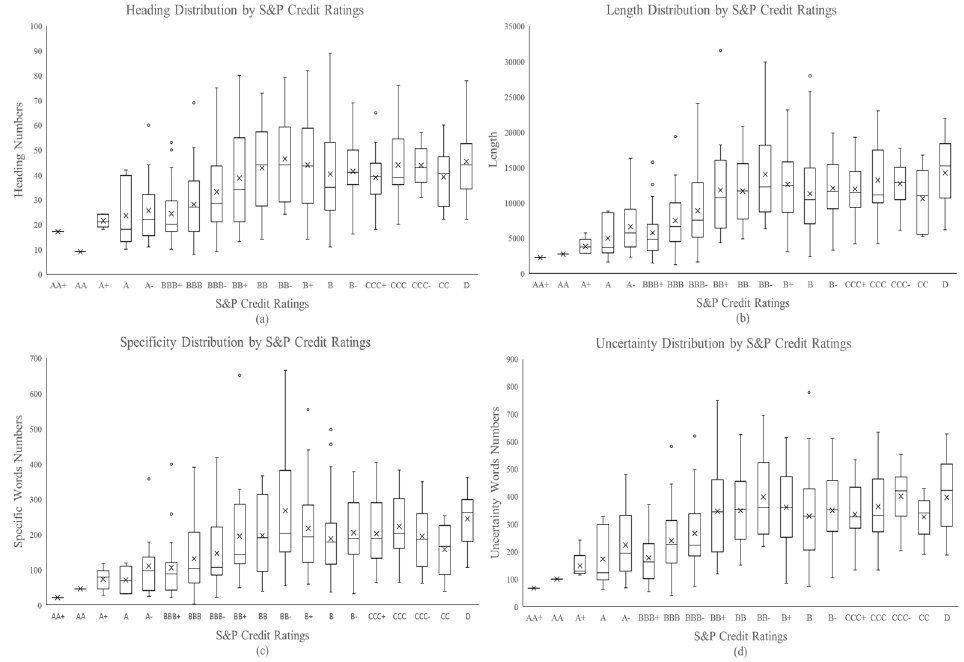
Figure 2. Four internal textural risk measures’ distribution of different rating grades.